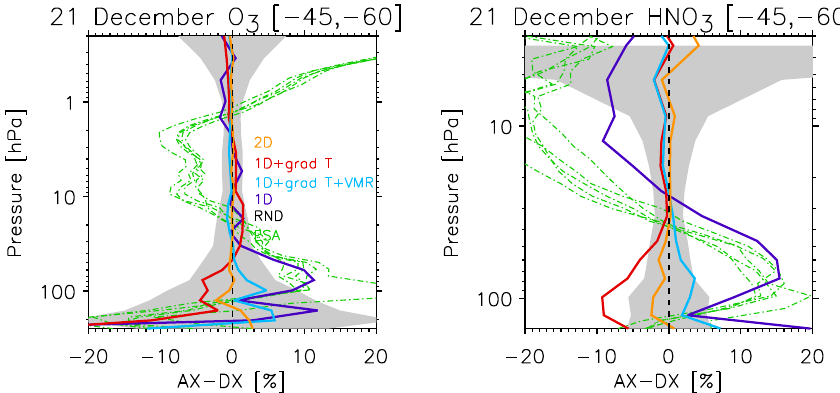
Figure 3. AX–DX differences for 21 December 2011 in the 45–60 ◦ S latitude band for O 3 and HNO 3 . The colour code is the same as in Fig.